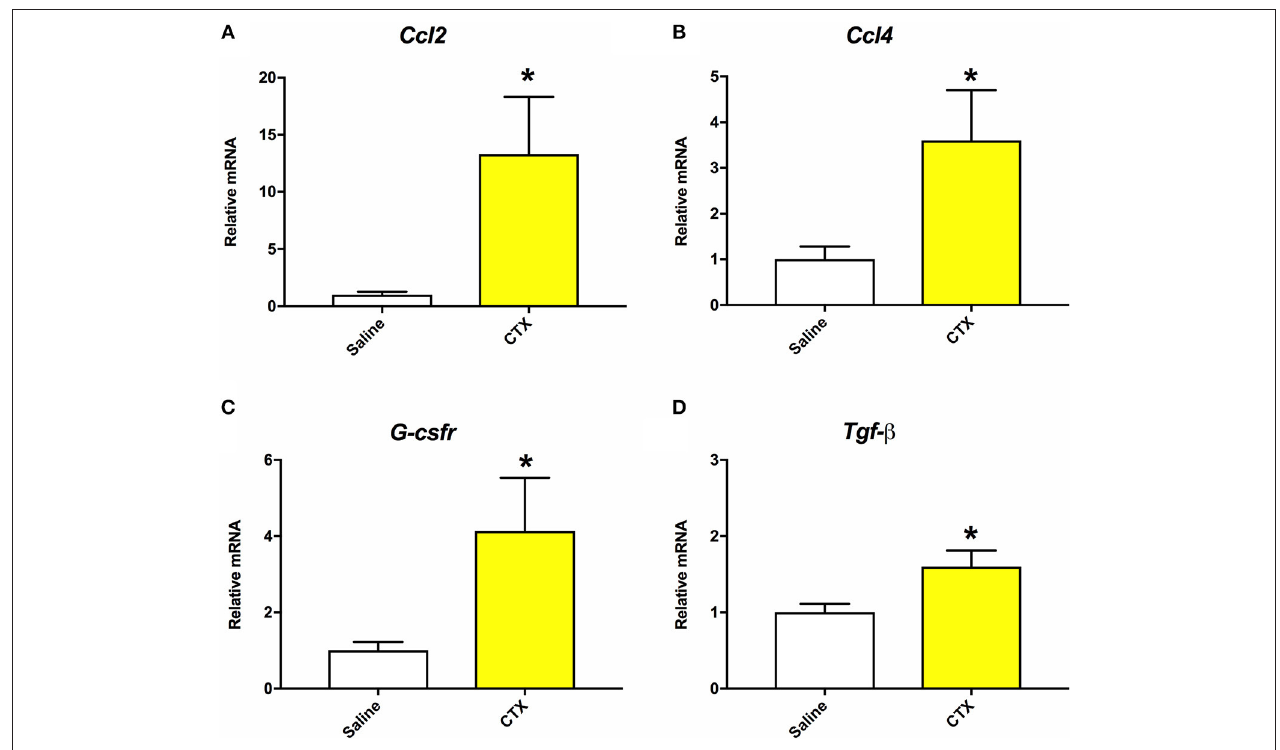
FIGURE 1 | Mice that were injected with CTX into the right hamstring had significantly increased mRNA levels of Ccl 2 (A) , Ccl 4 (B) , G-csfr (C) , and Tgf- β (D) in the hamstring muscle tissue compared to saline injected mice at 24h post-injury. There were no statistically significant differences on mRNA levels of Il-1 β or Tnf- α . *different than saline, p <